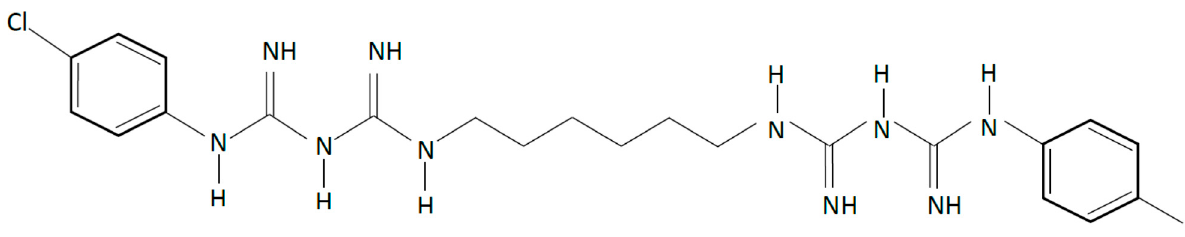
Figure 1. Chemical structure of chlorhexidine (CHX), a cationic compound with broad-spectrum antibacterial activity.